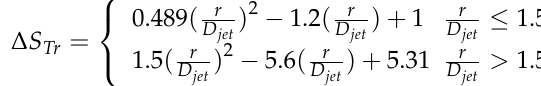
where ∆ S Tr is the hilltop speedup ratio at different radial positions.